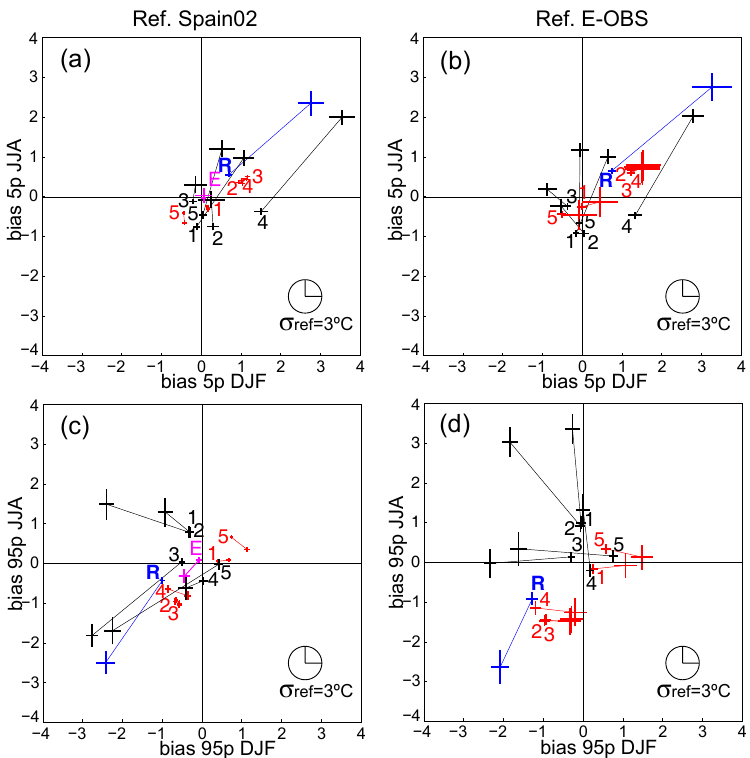
Fig. 2. Spatially averaged bias (in ◦ C) of 5th percentile of daily minimum (upper panels) and 95th percentile of daily maximum (lower panels) temperature with respect to Spain02 (left panels) and E-OBS (right panels). Each panel is a Cartesian (scatter) plot of the summer (JJA, y axis) bias against the winter (DJF, x axis) one. The origin (the unlabelled end) of a line represents the seasonal biases in the percentile when no correction is applied. The end of each line (the labelled end) represents the biases when the seasonal mean bias is corrected (Eq. 1). The line of each method is labelled according to Tables 1 and 2; note that the “D” (“S”) initial letters have been dropped for visual clarity. RCM (SD) lines are depicted in black (red). The lines corresponding to the reanalysis (blue) and to E-OBS (pink) are also depicted for reference. Finally, crosses at each end represent the spatial standard deviation of the biases. For clarity, σ values are rescaled; the value σ ref = 3 ◦ C is shown as